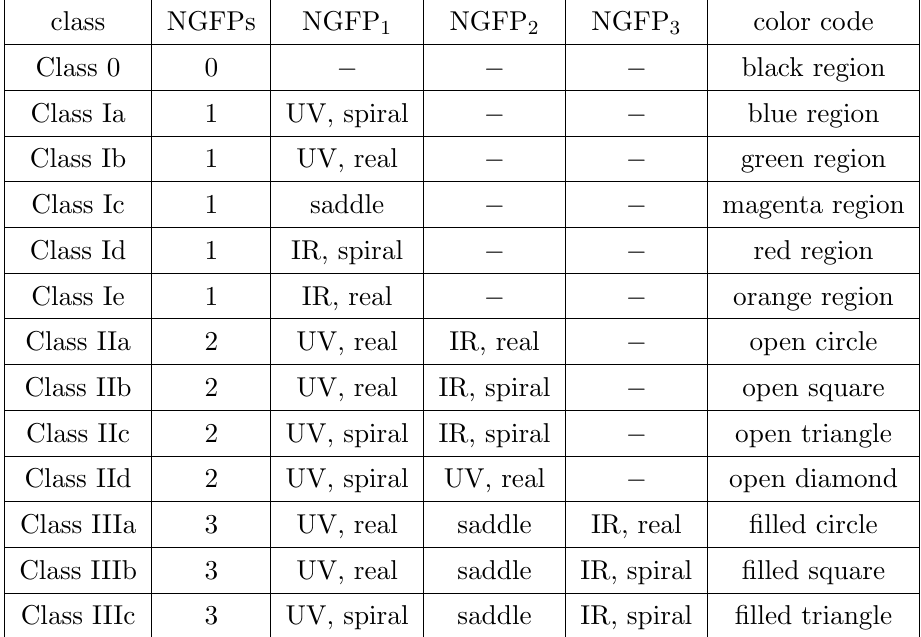
(cid:12)lled triangle Table 2 . Color-code for the (cid:12)xed point classi(cid:12)cation provided in (cid:12)gure 4. The column NGFPs gives the number of NGFP solutions while the subsequent columns characterize their behavior in terms of 2 UV-attractive (UV), one UV-attractive and one UV-repulsive (saddle) and 2 IR-attractive (IR) eigendirections with real (real) and complex (spiral) critical